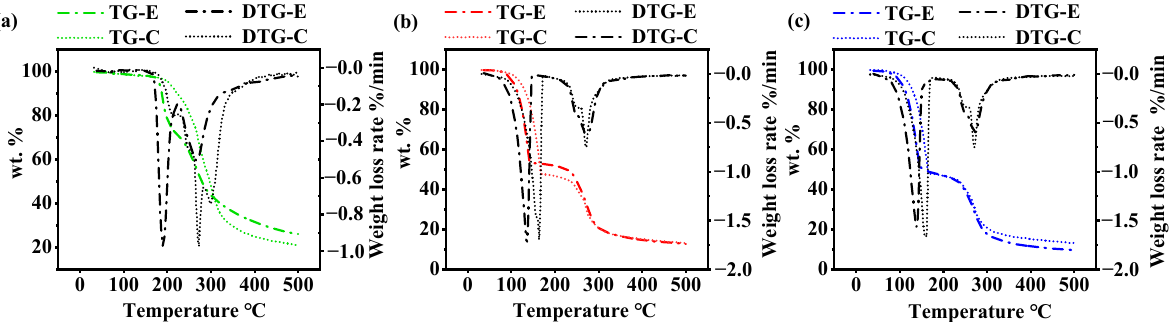
Figure 3. TG and DTG curves of co-pyrolysis (TG-E: results from experiment; TG-C: results from calculation of values from individual pyrolysis): ( a ) Glucose-UF; ( b ) Ethyl maltol-UF; ( c ) DMHF-UF.